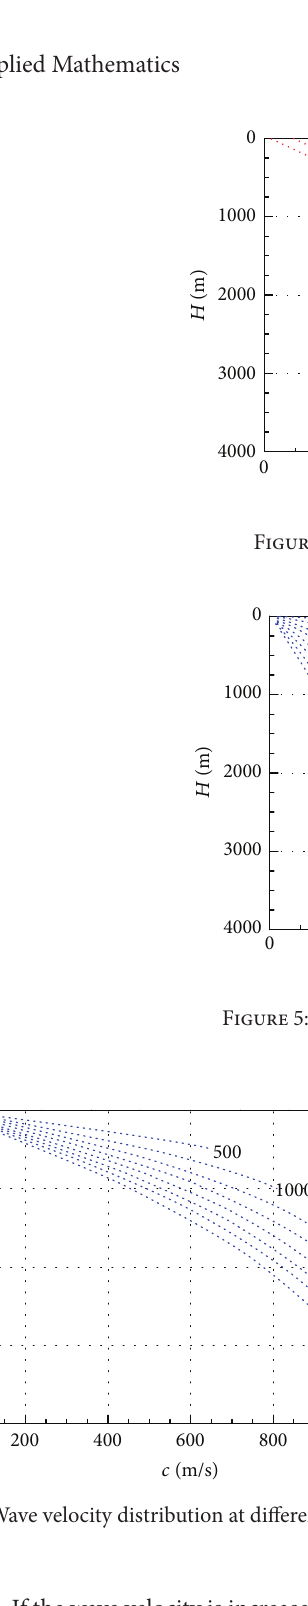
( 𝑄 𝑔 = 1.28 m 3 / h) occurs at different well depth (such as 𝐻 = 500 m , 𝐻 = 1000 m , 𝐻 = 1500 m , 𝐻 = 2000 m , 𝐻 = 2500 m , 𝐻 = 3000 m , 𝐻 = 3500 m , and 𝐻 = 4000 m),